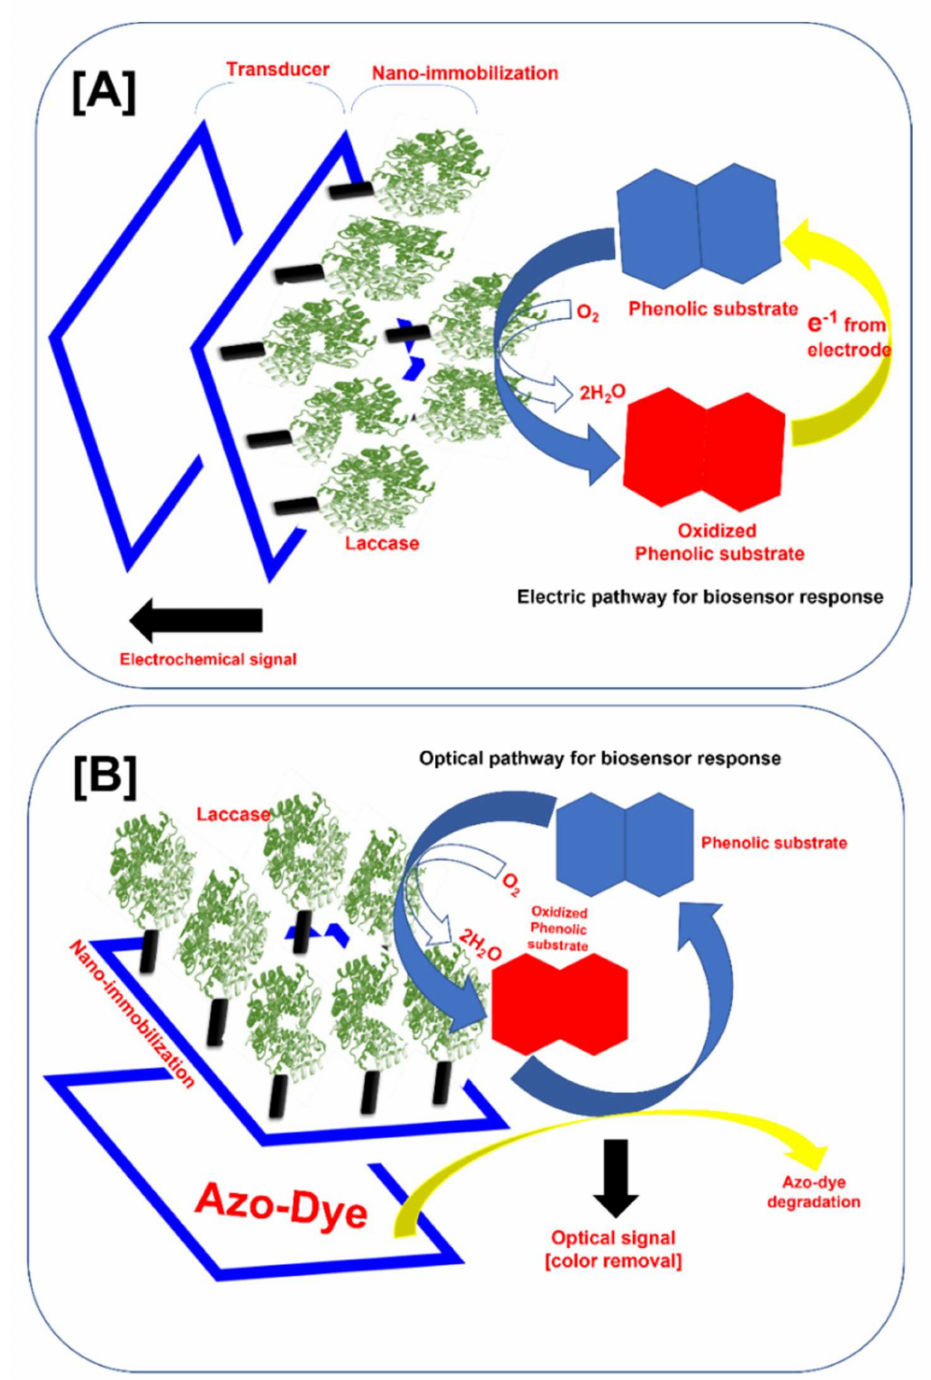
Figure 3. Typical structure of the nano-immobilized laccase-based biosensor for phenolic compound monitoring ( A ) Electrochemical sensor, and ( B ) optical